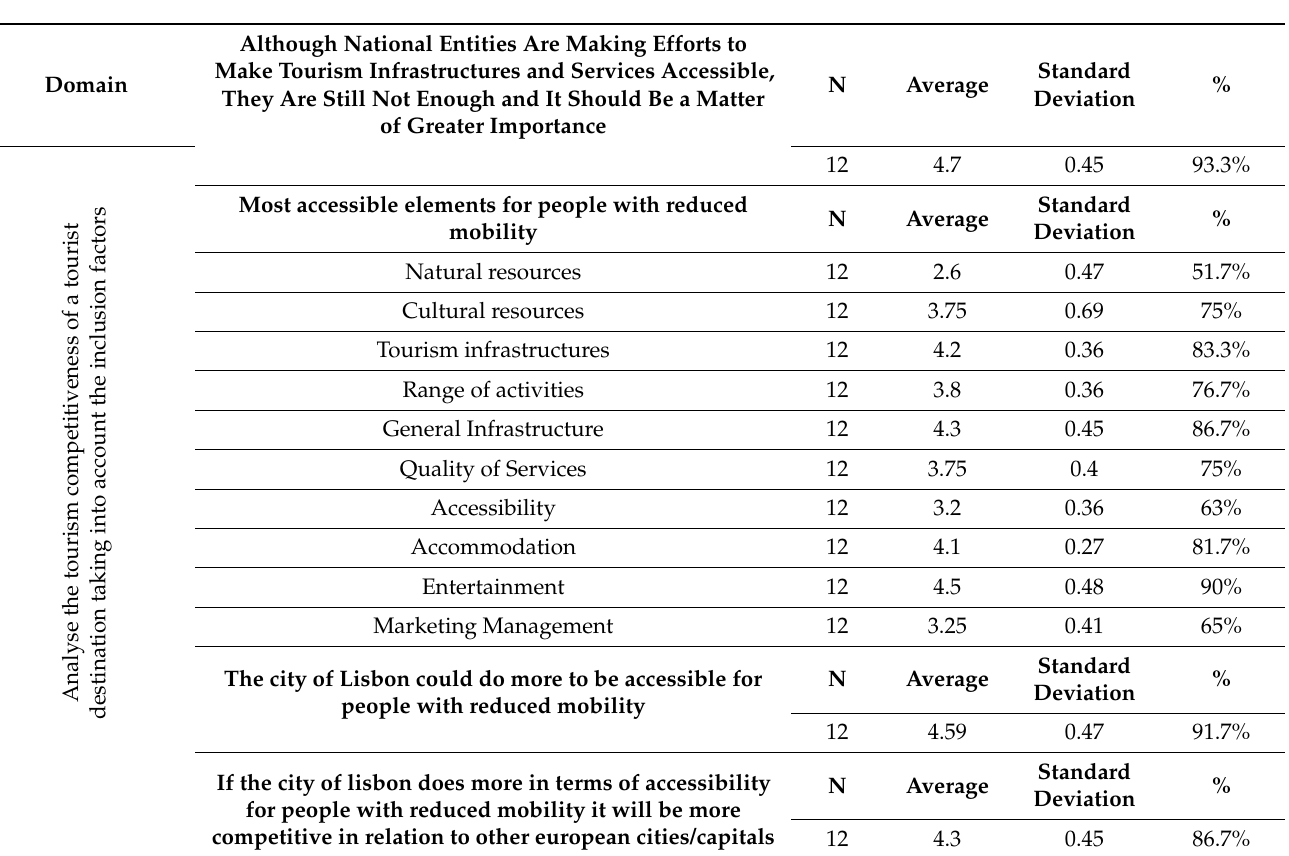
Table 16. Results of the second round of interviews—Domain, Analysing tourism competitiveness of a tourist destination taking into account the factors of inclusion. Source: Elaborated by the author.